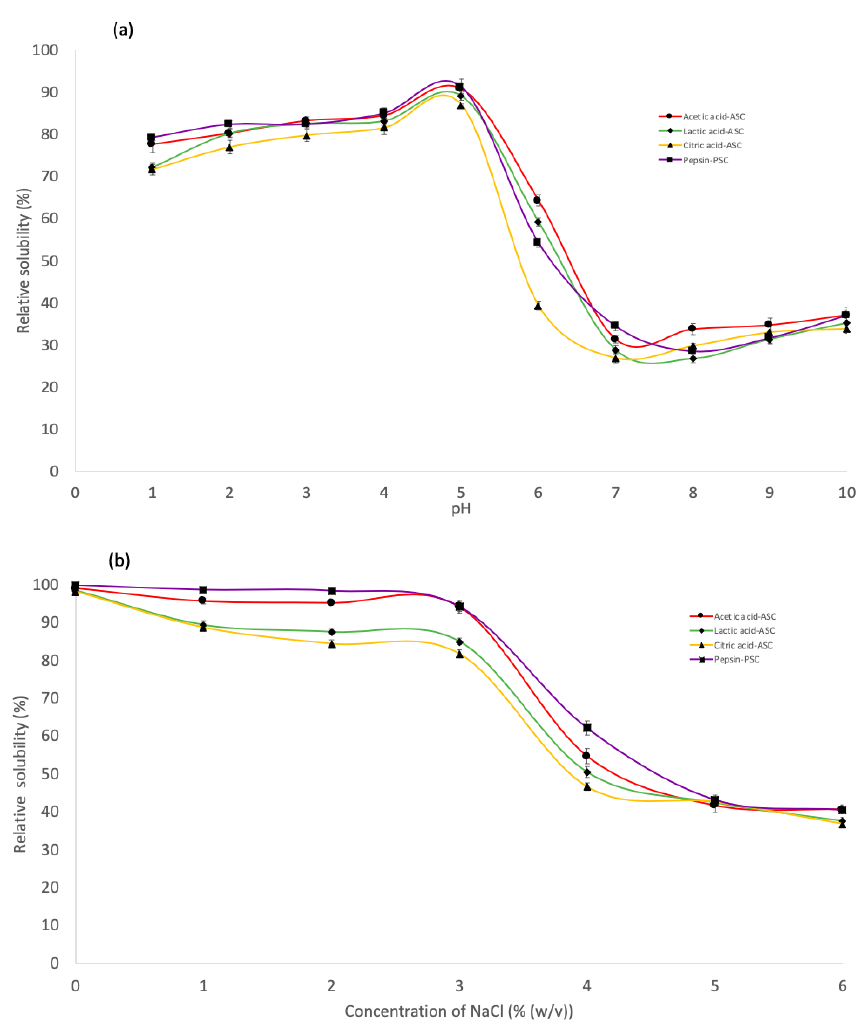
Figure 4. Relative solubility of the skin purple-spotted bigeye snapper collagens. ( a ) Effect of the collagen at different pH. ( b ) Effect of the collagen at different NaCl concentrations. Circle—Acetic acid collagen, AAC; Diamond—Lactic acid collagen, LAC; Triangular—Citric acid ollagen, CAC; Square—pepsin soluble collagen, PSC .